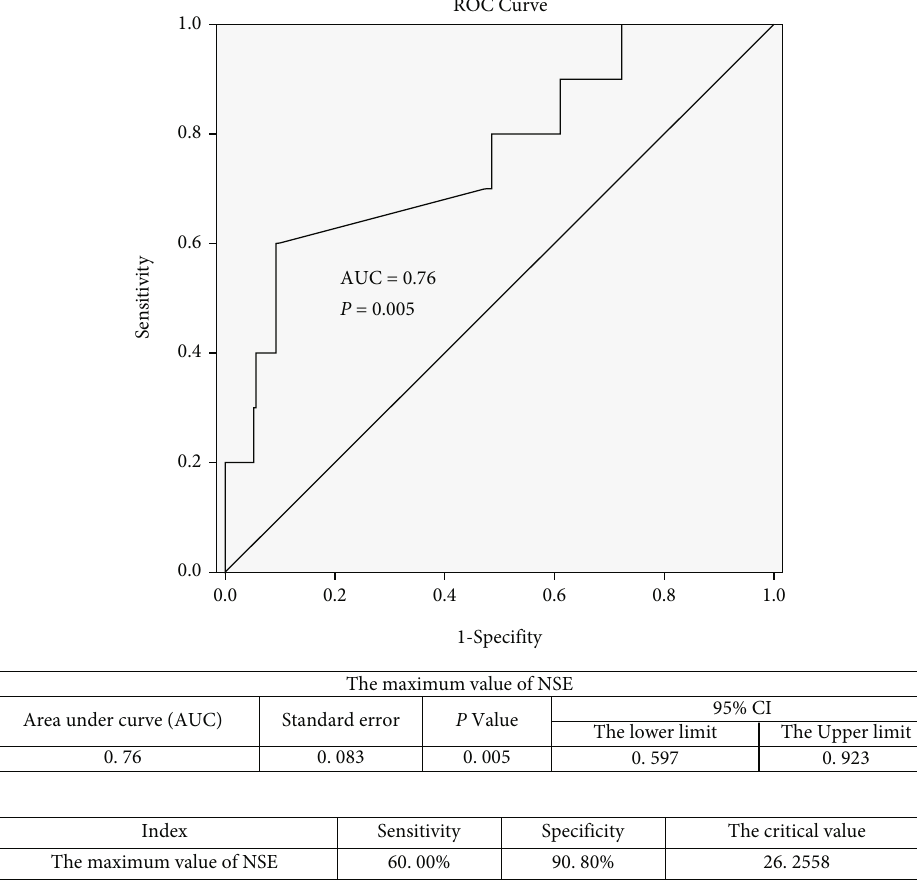
Figure 5: ROC curve, area under curve (AUC), and diagnostic threshold (Yoden index) of NSE